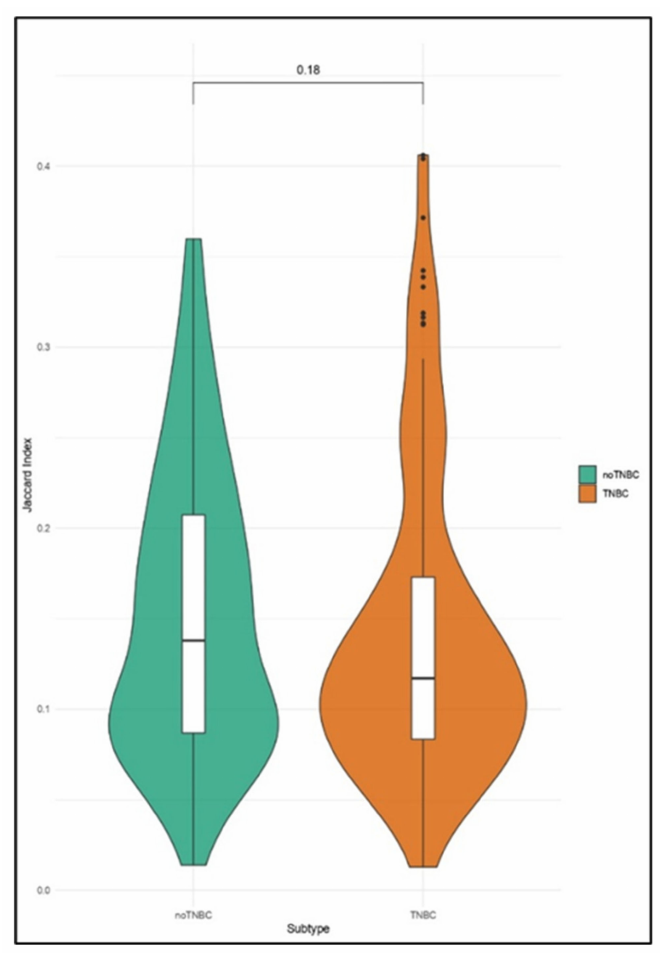
Figure 1. Violin plots showing the distribution of the Jaccard Indexes (JIs) computed by comparing the copy number alteration (CNA) profile of single circulating tumor cells (CTCs) and controls in non-triple negative breast cancer (TNBC) against